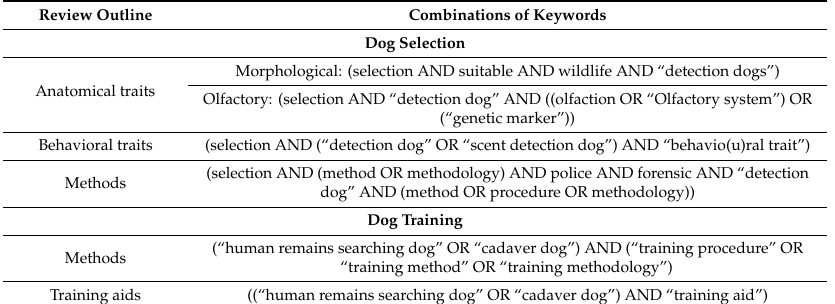
Table 1. Bibliographic research performed for each section of the present review using Scopus ® , Science Direct ® and Google Scholar ® between June and December